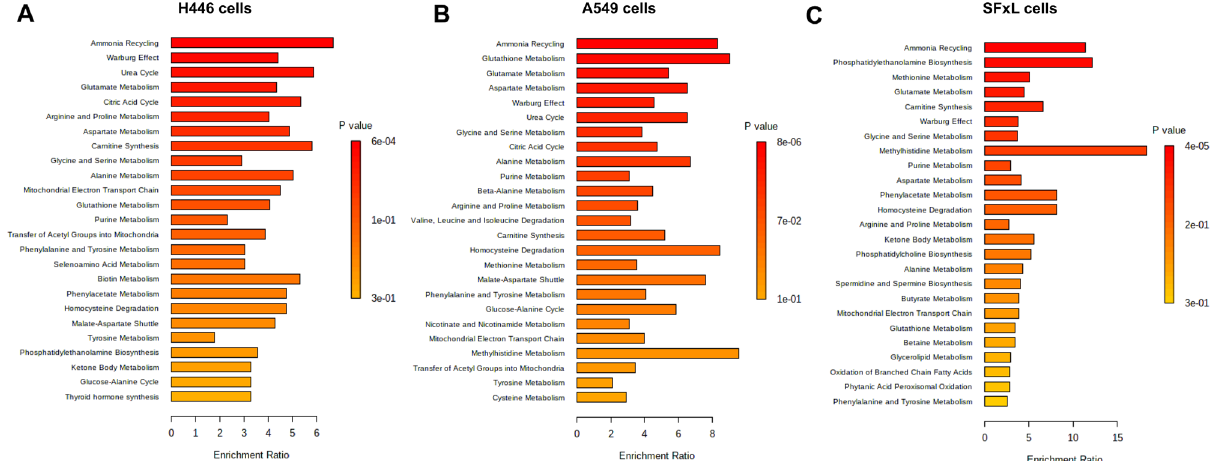
Figure 5. Investigation of enriched metabolic pathways: Metabolite Set Enrichment Analysis (MSEA), using significantly different metabolites between control and infected cancer cells. Overview of the top 25 enriched pathways for H446, A549, and SFxL cells in the panels, ( A ),( B ), and ( C ), respectively. MSEA investigates if a group of functionally or metabolically related metabolites is significantly enriched. It also eliminates the requirement of to preselect metabolites based on some cut-off threshold.